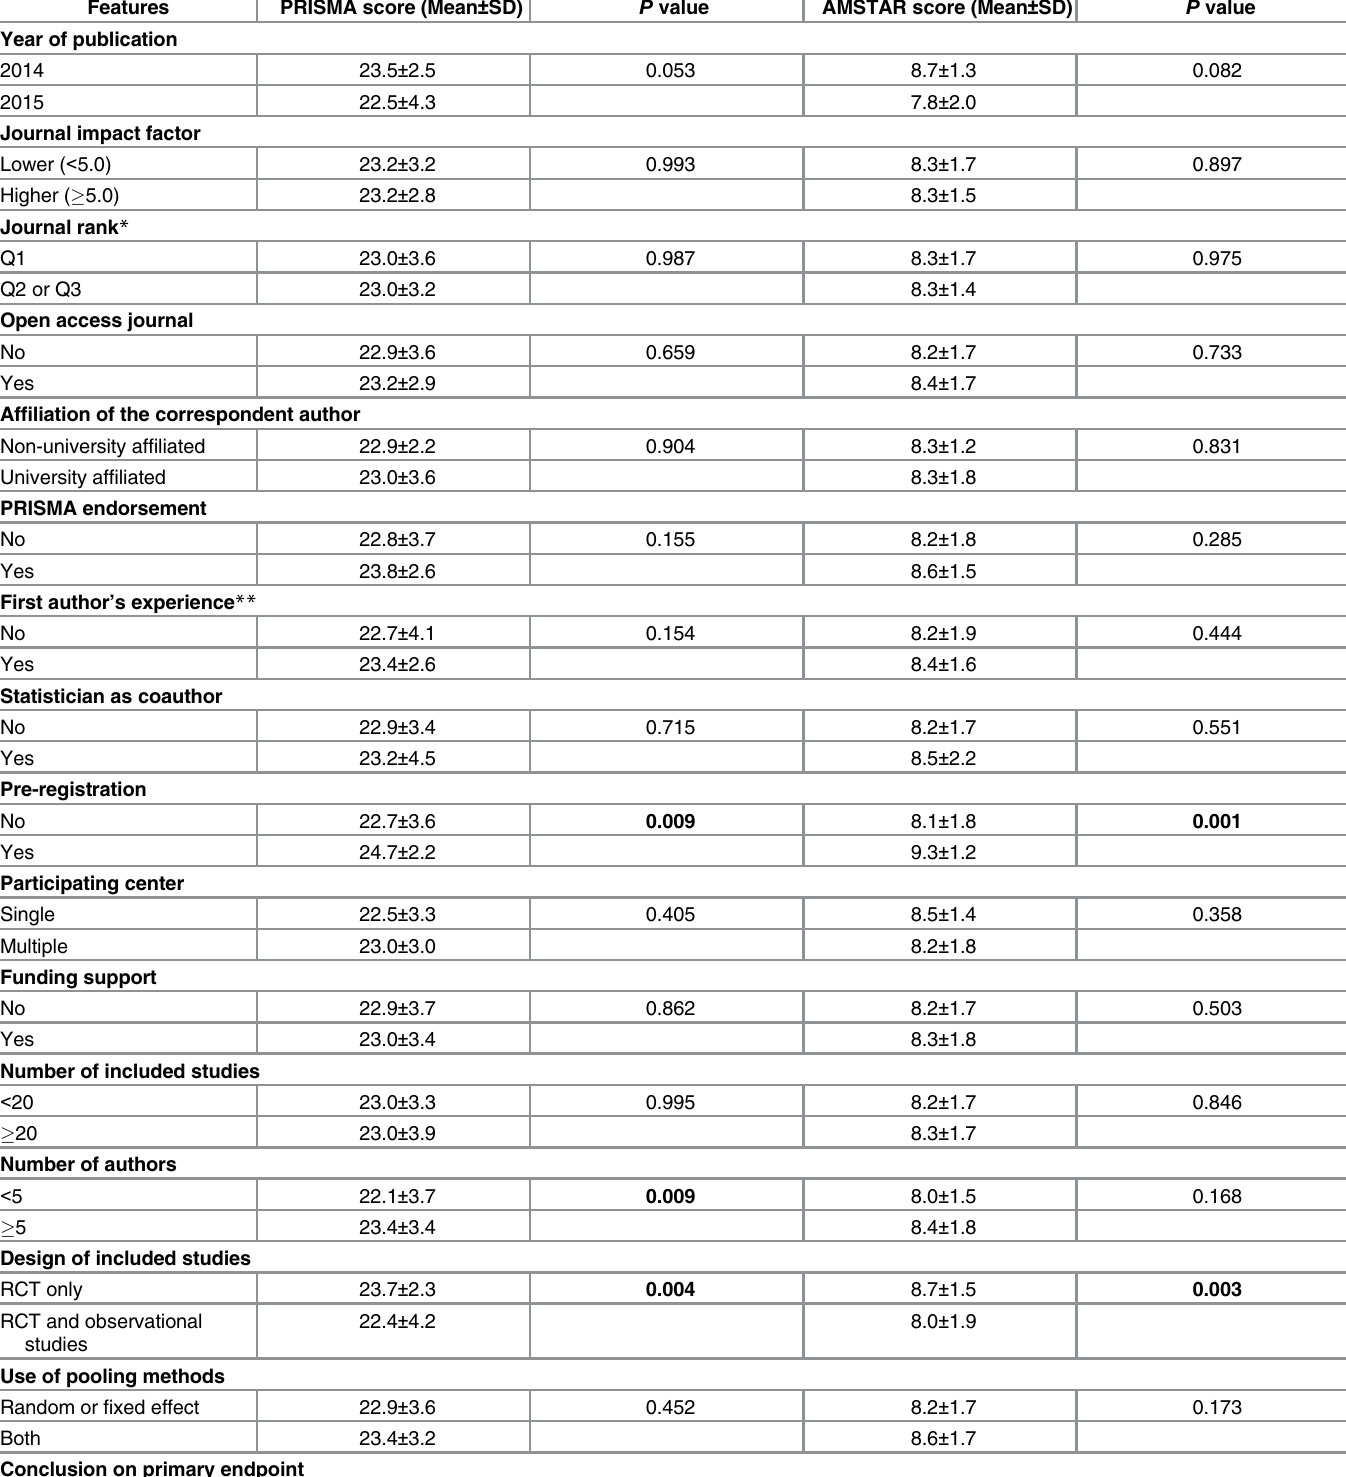
Table 2. Characteristics of included MAs and comparison of their